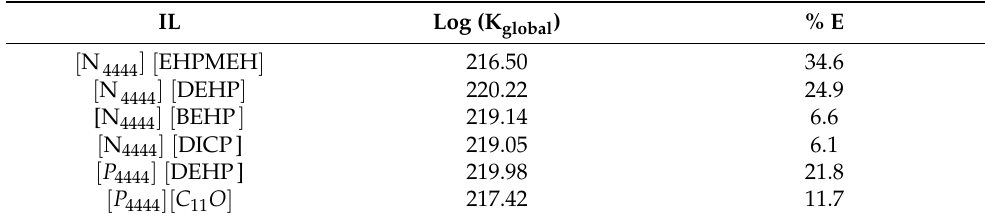
Table 1. COSMO-RS and experimental [23] calculations for lithium extraction.